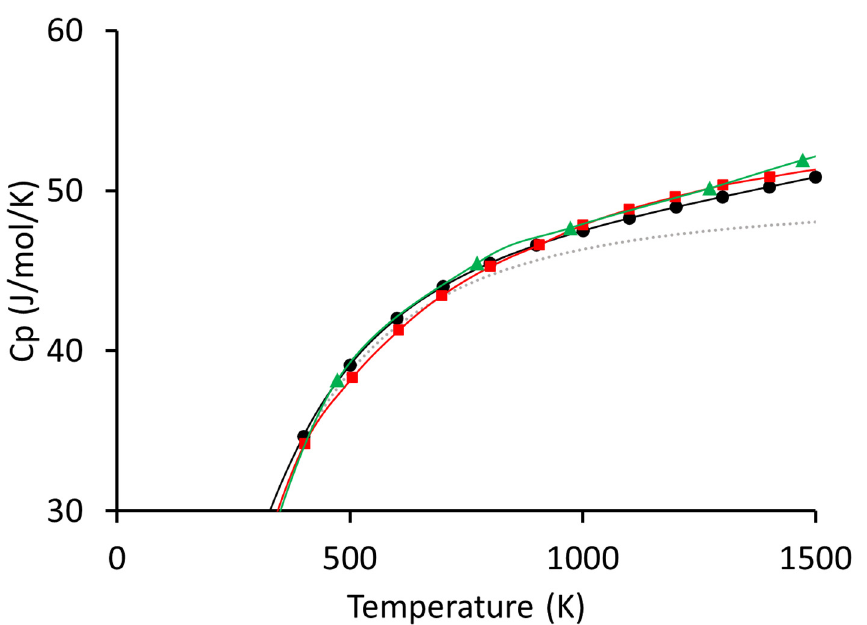
Figure 2. Shown above are our results compared to the experimental data available in the literature. The grey dotted line represents the calculated values of C v ( T ) (included for reference), the black circles are the C p ( T ) values from the present work, the red squares are from reference [28], and the green triangles are from reference [29].